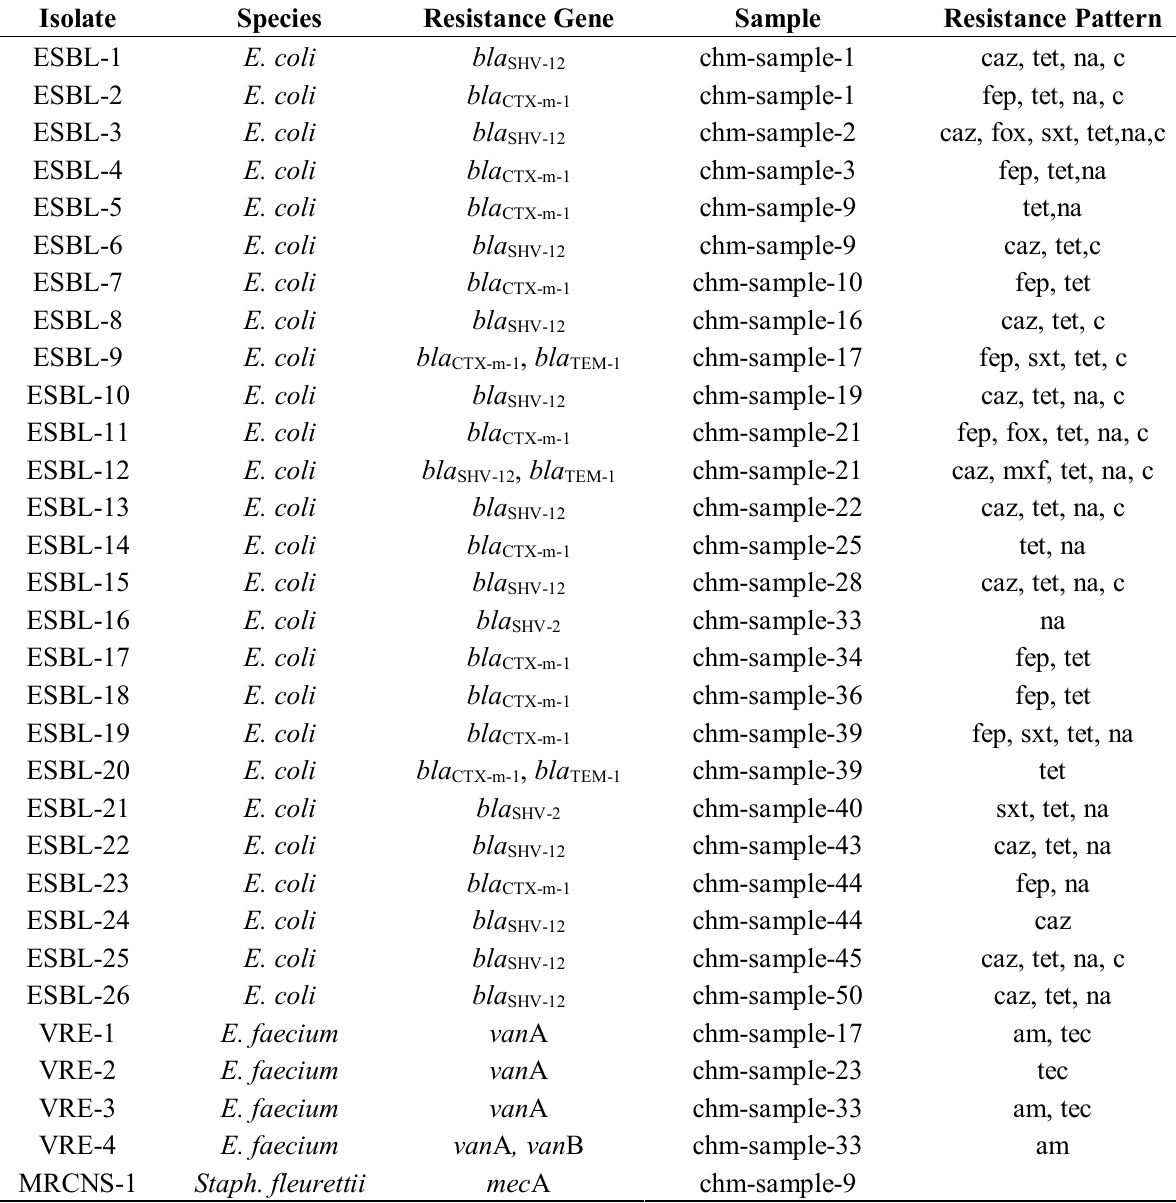
Table 1. Resistance genes and antibiotic resistance profile of multiresistant bacteria isolated from chicken